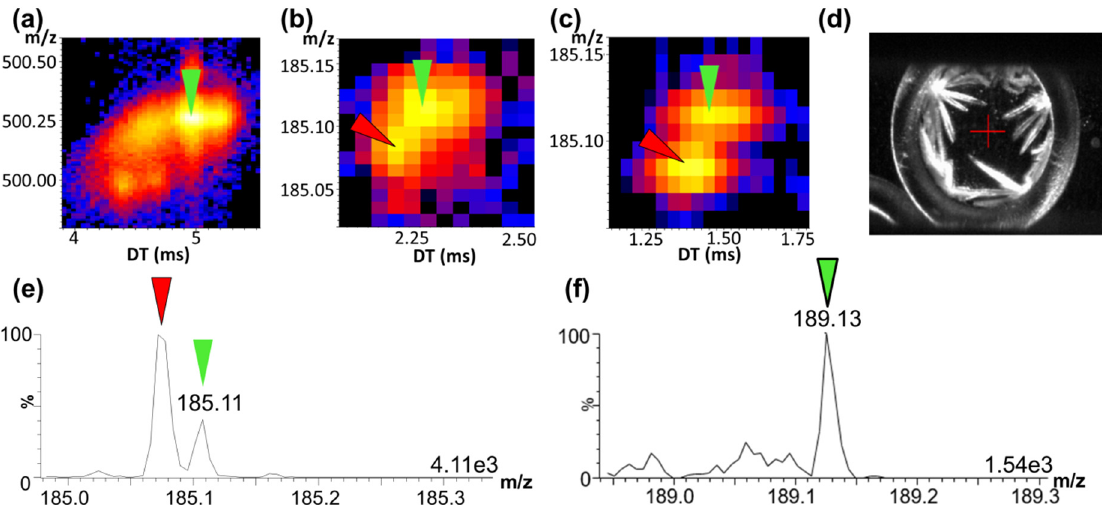
Figure 1. Two-dimensional mass-to-charge ratio ( m / z ) vs. drift time (DT) maps of native osimertinib (OSN, m / z 500.25) directly spiked in plasma ( a ), the major fragment of OSN ( m / z 185.10) using a single-ion reflection mode (sensitivity mode) ( b ), and a two-ion reflection mode (resolution mode) ( c ). Aspect of 2,5 dihydroxybenzoic acid (2,5-DHB) crystals after direct spiking and crystallization from untreated plasma ( d ). Mass spectra of OSN spiked at 100 ng/mL ( e ) and its internal standard [ 13 C, 2 H 3 ]-OSN ( f ) in untreated plasma with 2,5-DHB. The maximum intensities of the mass spectra are indicated at the bottom right of the spectra. OSN signals are marked with green arrows, internal standard signals with green arrows with a black border, and interfering ion signals with red arrows.